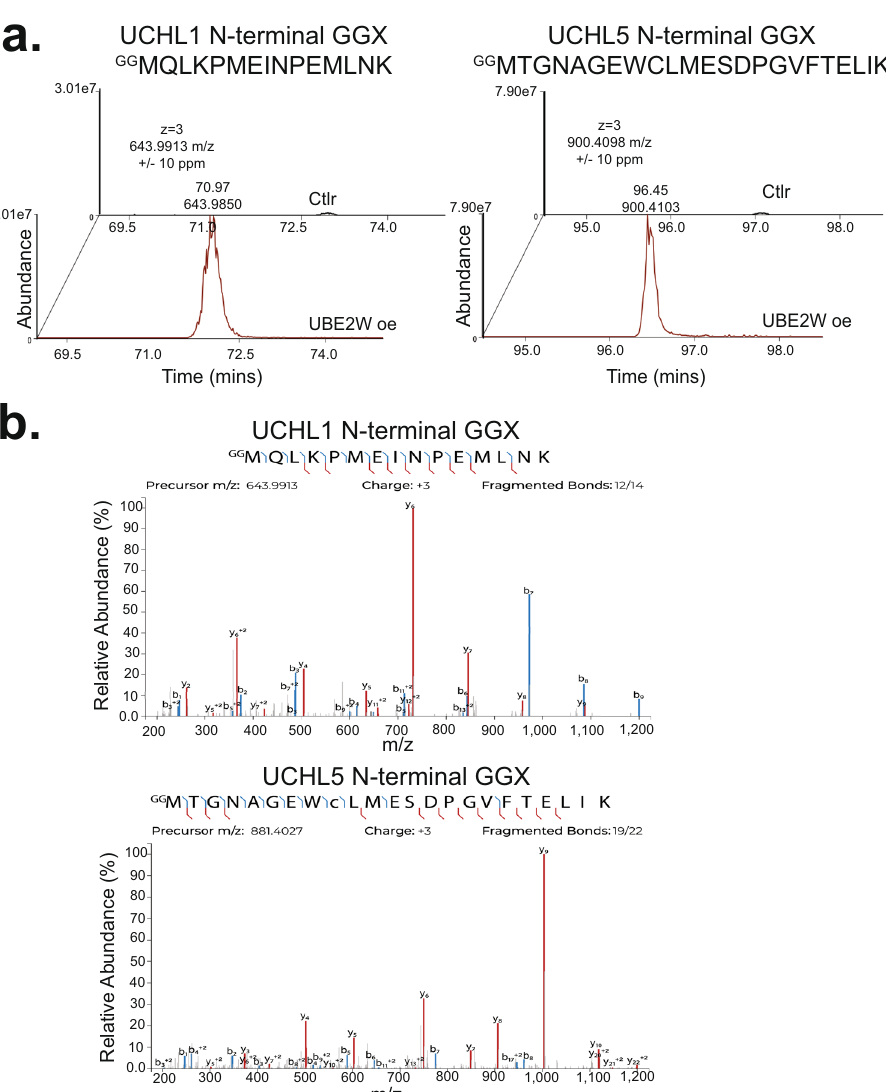
Fig. 6 MS identi fi cation of UCHL1 and UCHL5 N-terminal Ub peptides. a Extracted ion chromatograms (±10ppm) for N-terminal tryptic GGX peptides GG MQLKPMEINPEMLNK and GG MTGNAGEWCLMESDPGVFTELIK of UCHL1 and UCHL5, respectively, in control and UBE2Woe conditions from GGX-IAP- LC-MS/MS experiment. b MS/MS peptide spectral matches for N-terminal tryptic GGX modi fi ed peptides GG MQLKPMEINPEMLNK (triply charged, 643.9907m/z) and GG MTGNAGEWCLMESDPGVFTELIK (triply charged, 900.4094m/z). Detected b- and y- ions highlighted in blue and red,